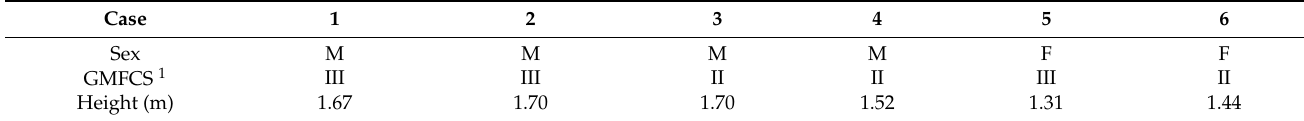
Table 2. Characteristics of participants. ( B ) bilateral